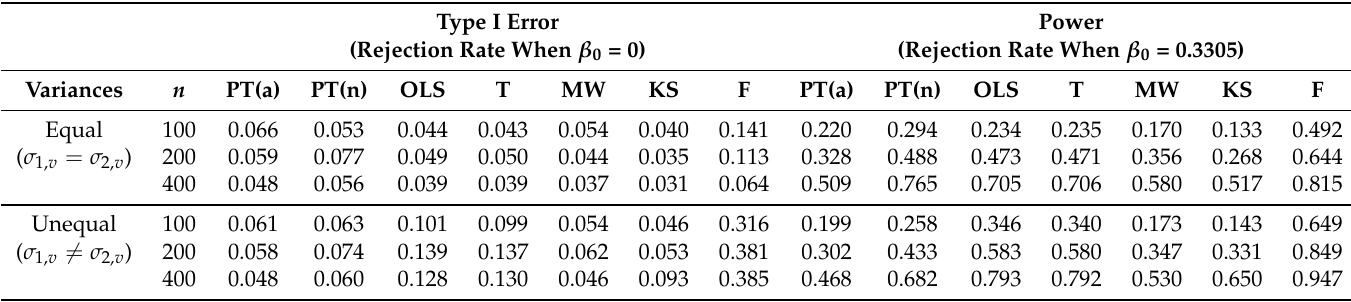
Table 2. Type I error and power of the multiple input case with equal and unequal error variances when the true production function is not additive.